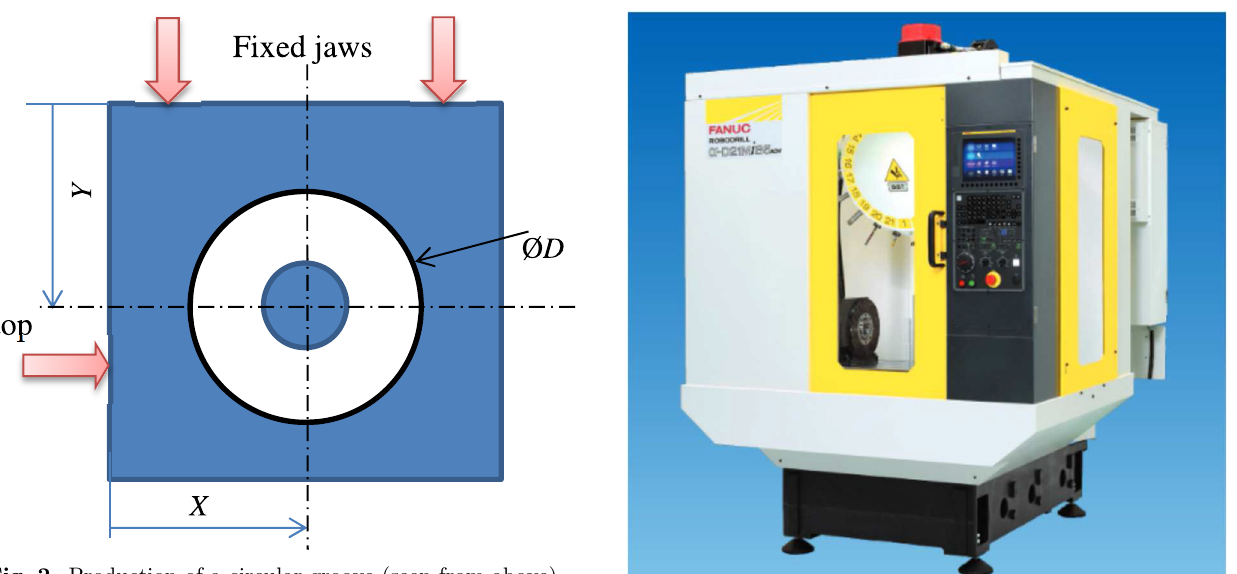
Fig. 2. Production of a circular groove (seen from above).